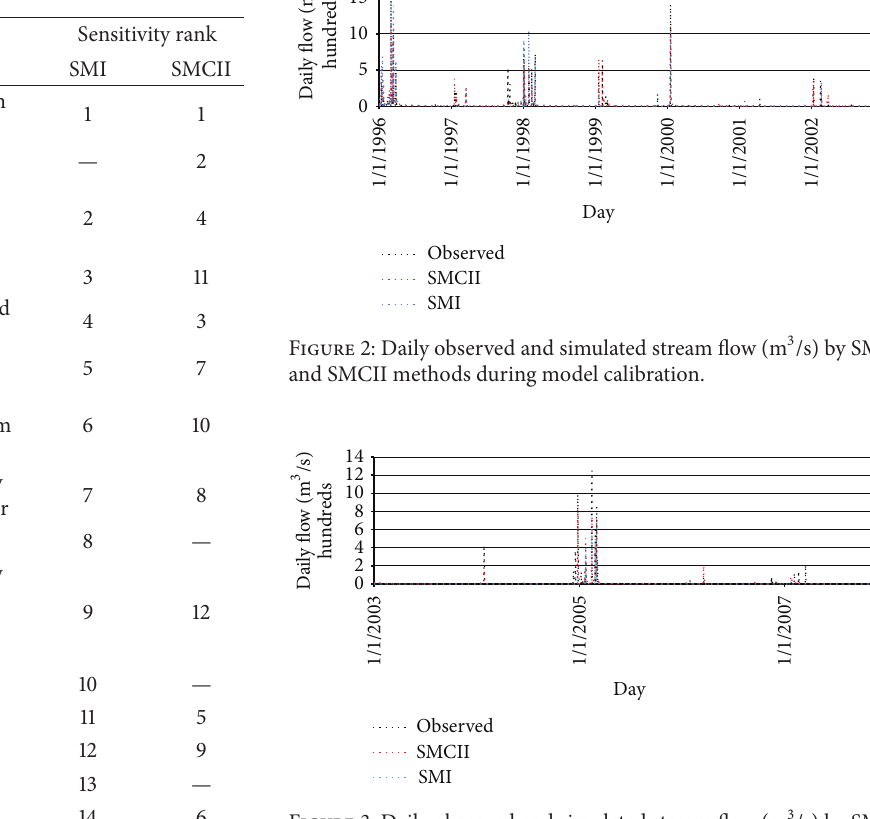
Table 2: Sensitivity ranking of parameters for SMI and SMCII methods derived by SUFI-2 algorithm.